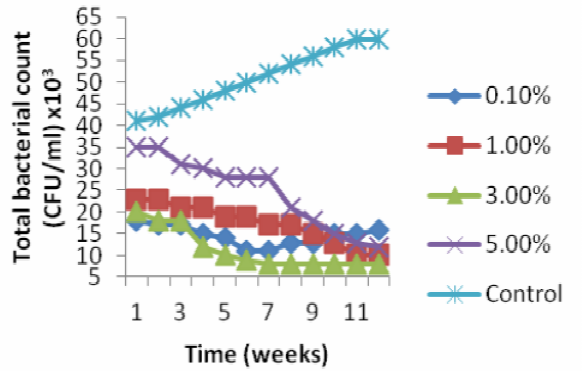
Fig. 1. Changes in the total bacterial counts of varying concentrations of sodium benzoate preserved powder of mango seed stored at room temperature for 12